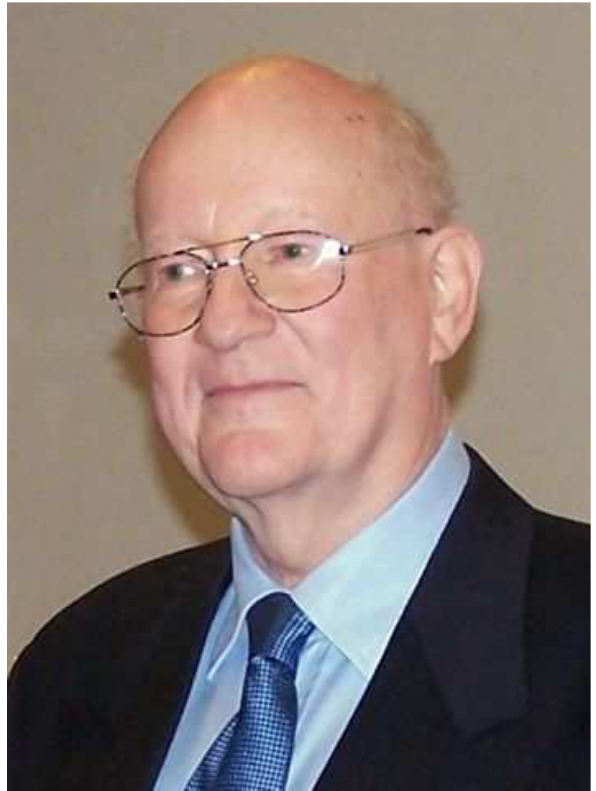
Figure 1. Tor Hagfors, Director of EISCAT in 1975–1982 (Photo by Andreas Blome, MPI f¨ur Sonnensystemforschung, on the occa- sion of Hagfors’s 75th birthday on 3 February